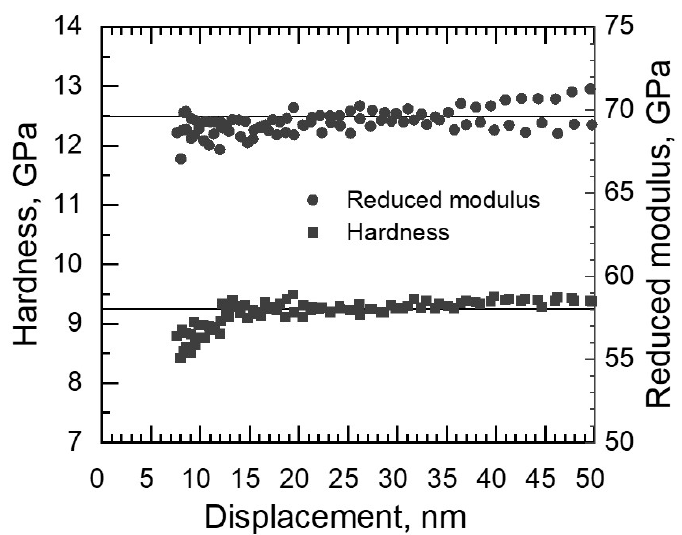
Figure 2. Nanoindentation test measurement results on fused quartz with hardness of 9.25 GPa and reduced modulus of 69.6 GPa (horizontal lines).